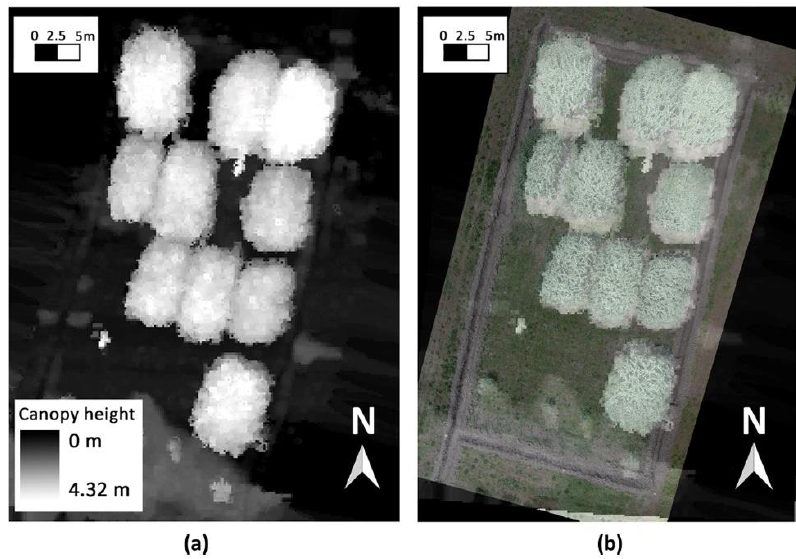
Figure 6. Established crop height model (CHM). ( a ) CHM of the experimental plot in the moderate drought stress (mDr) treatment; ( b ) CHM overlapped with an orthophoto of the mDr treatment.